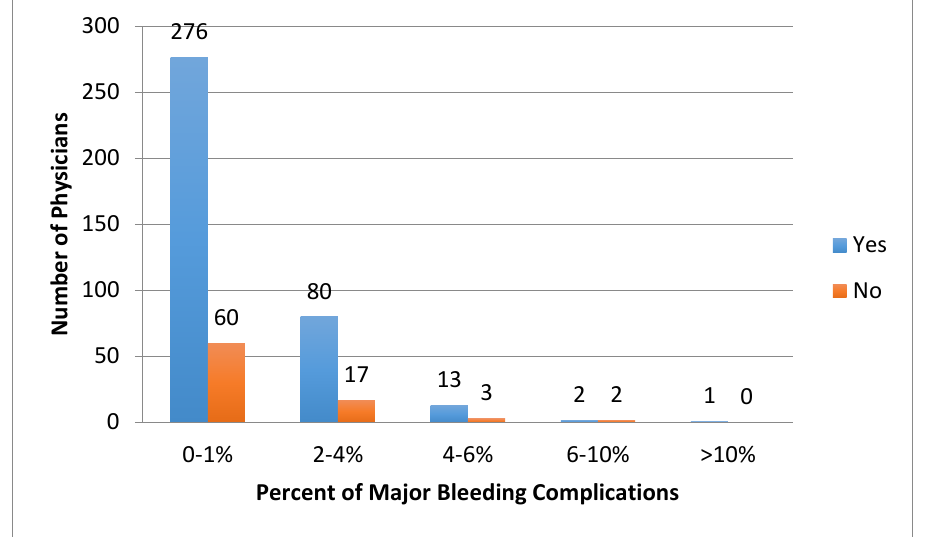
Figure 7. Comparison of self-reported percentages of thrombolysis cases that are complicated by major bleeding complications between practitioners who monitor fibrinogen and those that do not ( p = 0.15). Use of adjunctive systemic anticoagulation during thrombolysis varied.